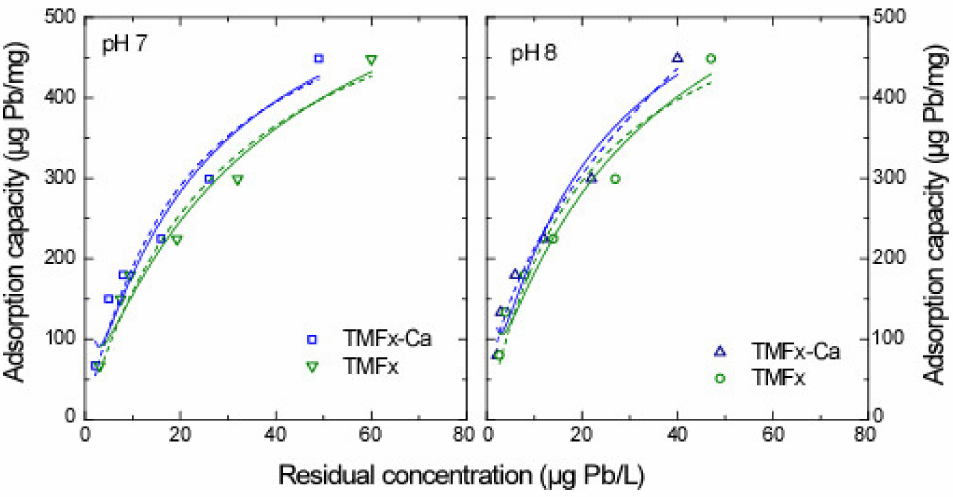
Figure 6. Pb adsorption isotherms in NSF water matrix for pH values 7 and 8. Solid and dashed lines represent the Freundlich and Langmuir fittings, respectively. Table 3. Freundlich and Langmuir fitting parameters, regarding Pb adsorption isotherm data. Adsorbent